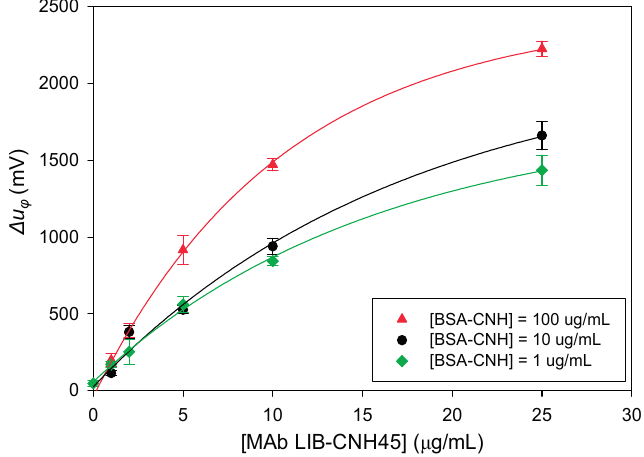
Figure 9. Optimization of the carbaryl LW immunosensor assay. Signal variation ( Δ u 15 min of sample injection at 20 μ L/min) as a function of LIB-CNH45 MAb concentration. Triangles for the hapten-conjugate of 100 μ g/mL; circles for the hapten-conjugate of 10 μ g/mL; and diamonds for the hapten-conjugate of 1 μ